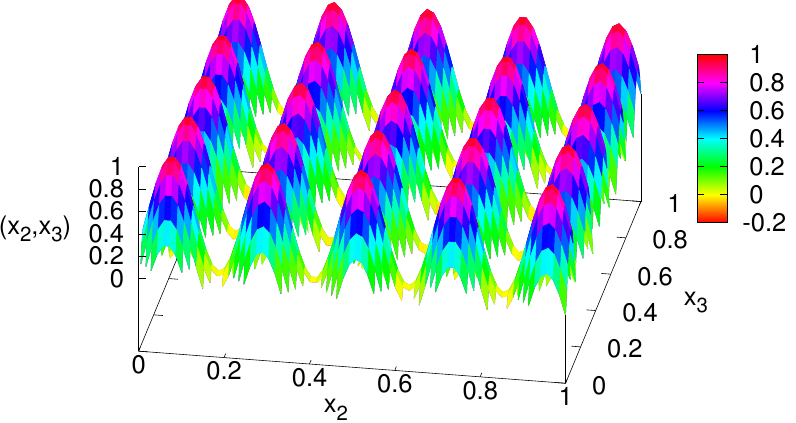
Figure 2. Sample harmonic distribution of volume force terms from Equation (6) ( N k =